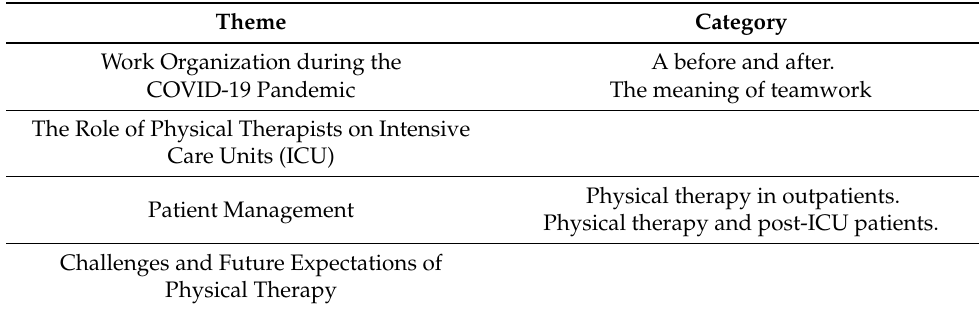
Table 3. Themes and categories